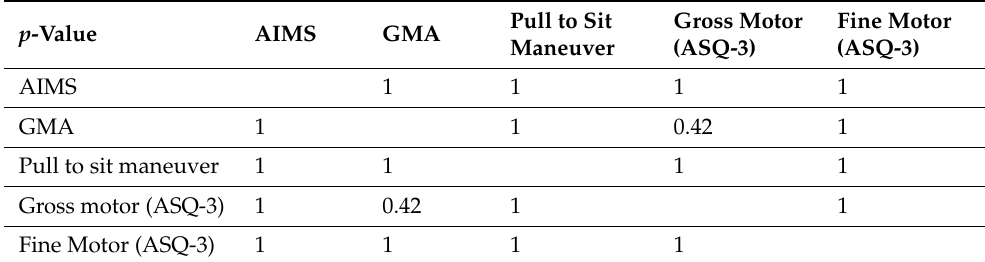
Table 3. Difference between the AIMS, GMA and pull to sit item, Dunn’s Test p = >0.999999. p -Value